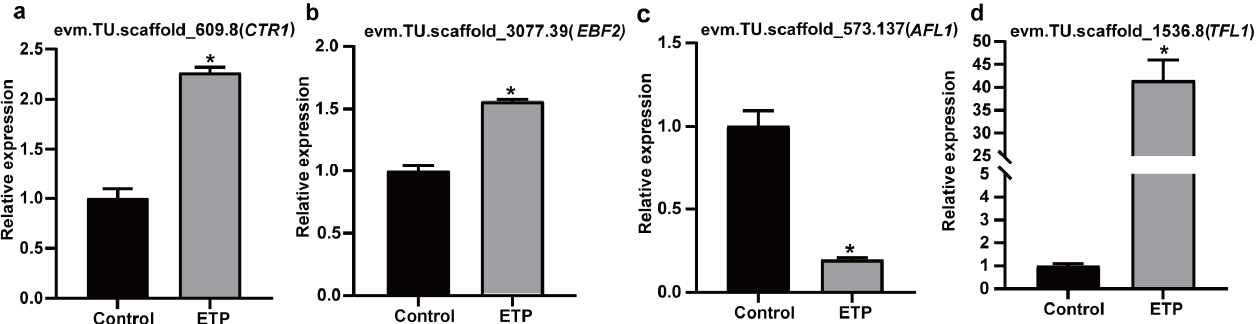
Figure 6. ( a – d ) qRT-PCR veri fi cation of di ff erentially expressed genes (DEGs) associated with the ethylene signaling pathway and fl owering regulation. CmEF1 α was used as the loading control. The values are presented as mean ± standard deviation ( n = 3). Transcript abundance was estimated using the 2 −ΔΔ Ct method. The signi fi cance of the di ff erences was determined using Student’s t -test (* p < 0.05).